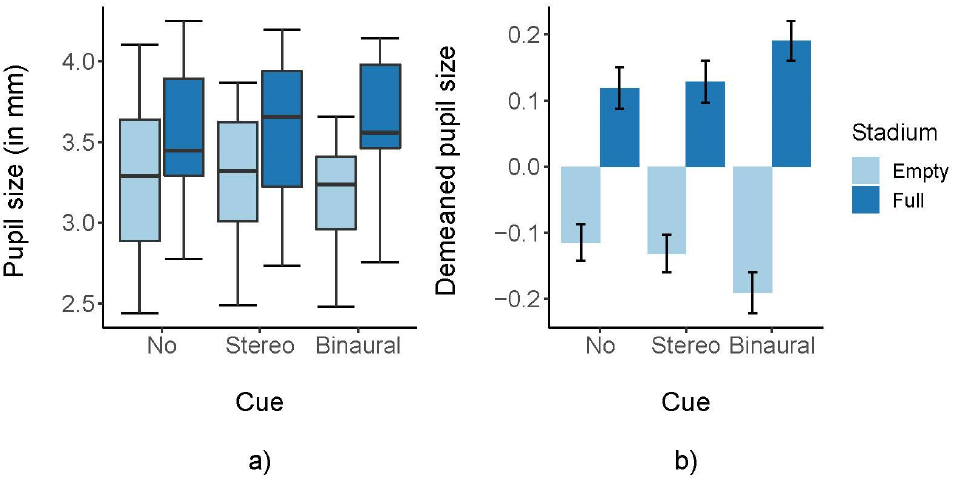
Figure 5. ( a ) Boxplot with median pupil sizes and ( b ) a barplot with demeaned pupil size and error bars indicating standard errors of mean for 17 participants in the no cue, stereo and binaural cue conditions for the empty and full stadium conditions.